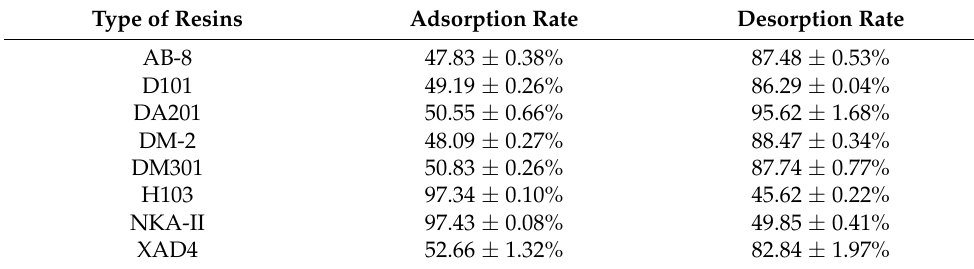
Table 5. The adsorption and desorption rates of 8 resins.